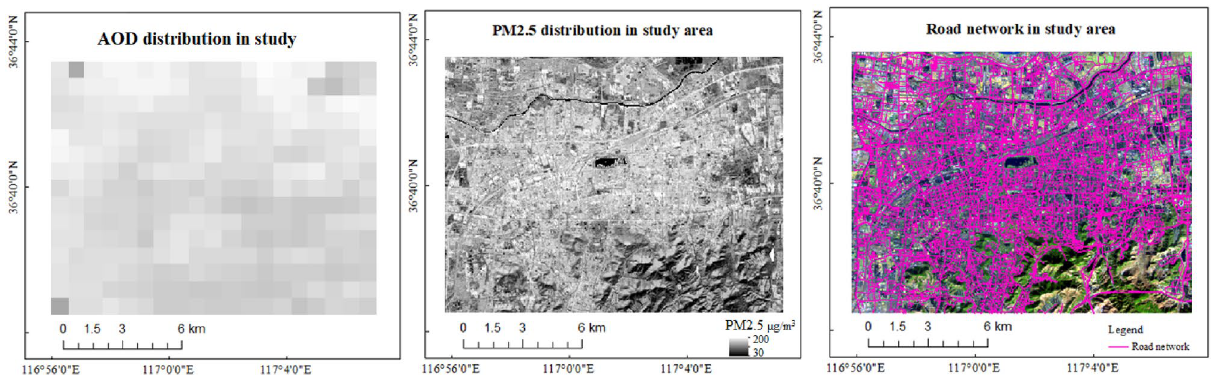
Figure 7. AOD (1000 m), PM2.5(30 m) and road network in the study area. The PM2.5 values along the road network were significantly higher than those in other areas, i.e., the higher resolution can better retrieve the relationships between the roads and air quality. Map created in ArcMap 10.5 of the Environmental System Resource Institute, Inc. (https:// www. esri. com/ softw are/ arcgis/ arcgis- for- deskt